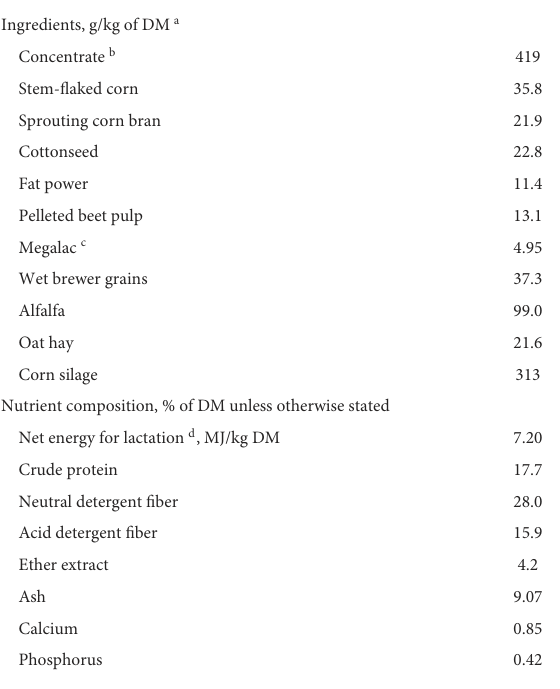
TABLE 1 The ingredients and nutrient composition of the basal